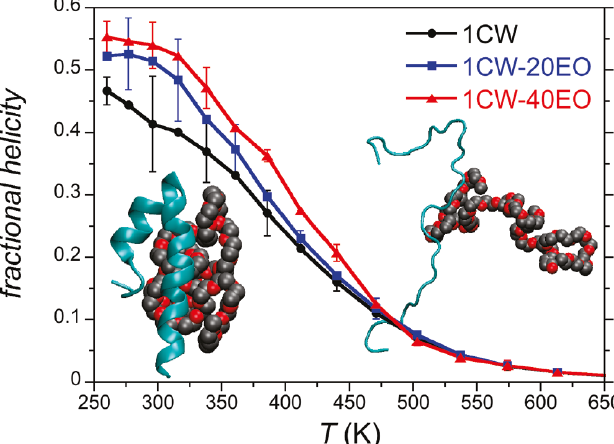
Figure 3. Helix melting curves of the pure peptide (1CW) and its conjugates with 20- and 40-mers of ethylene oxide (EO). (Reprinted with permission from [94]. Copyright 2013 American Chemical